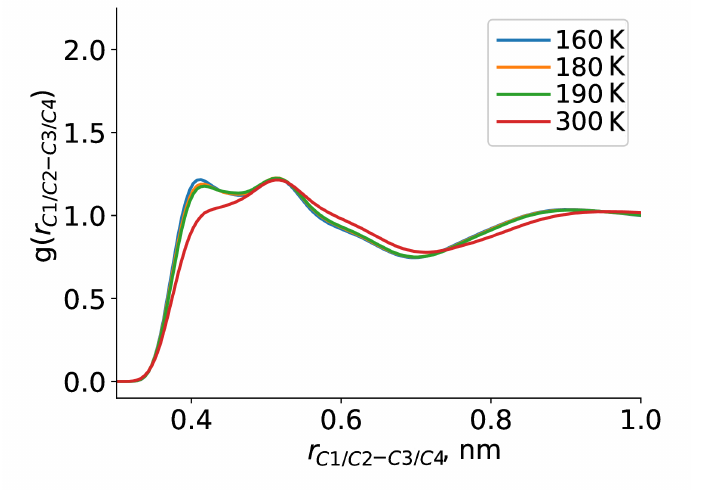
Figure 7. Radial distribution function between C1/C2 and C3/C4 atoms of DBP with